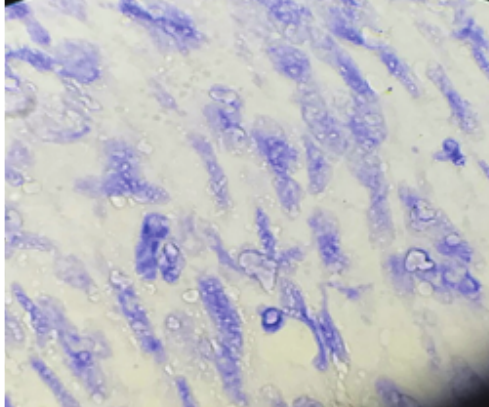
Figure 5: Desmin is negative—immunochemistry (magnification x